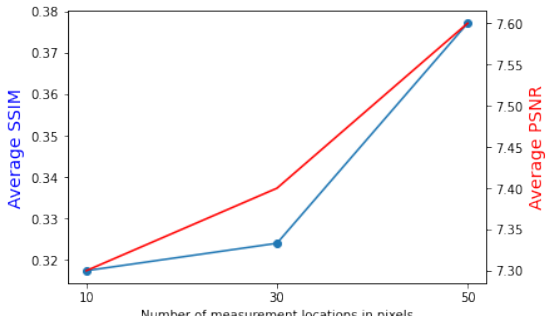
Figure 9. Average SSIM (in blue line) and PSNR (in red line) of the proposed EMGAN with a varying number of measurement points.